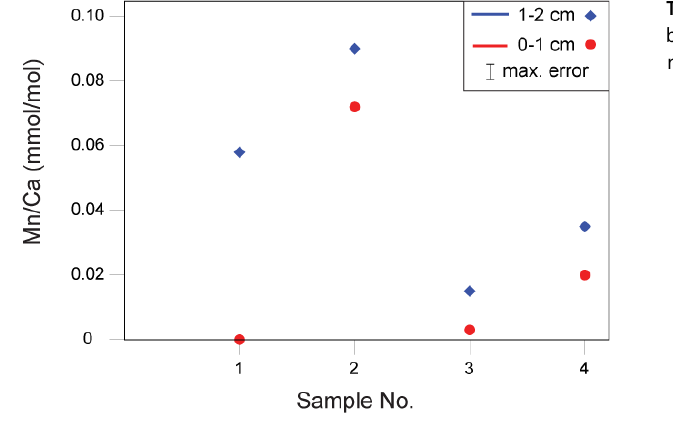
Fig. 4a. Mn/Ca of G. turgida for the Skagerrak for 0–1cm (circles, red) and 1–2cm (diamonds, blue) sediment depth, showing higher values deeper in the sediment corresponding to lower dissolved oxy- gen concentrations deeper in the sediment. Maximum error corre- sponds to the largest analytical error for the displayed samples.